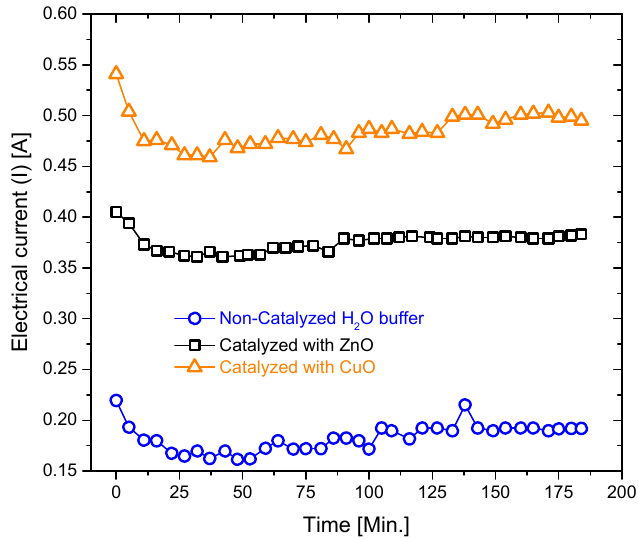
Figure 5. Electrical current versus period of Time characteristics for the non-catalyzed system and the catalyzed systems with CuO NPs and ZnO NPs.